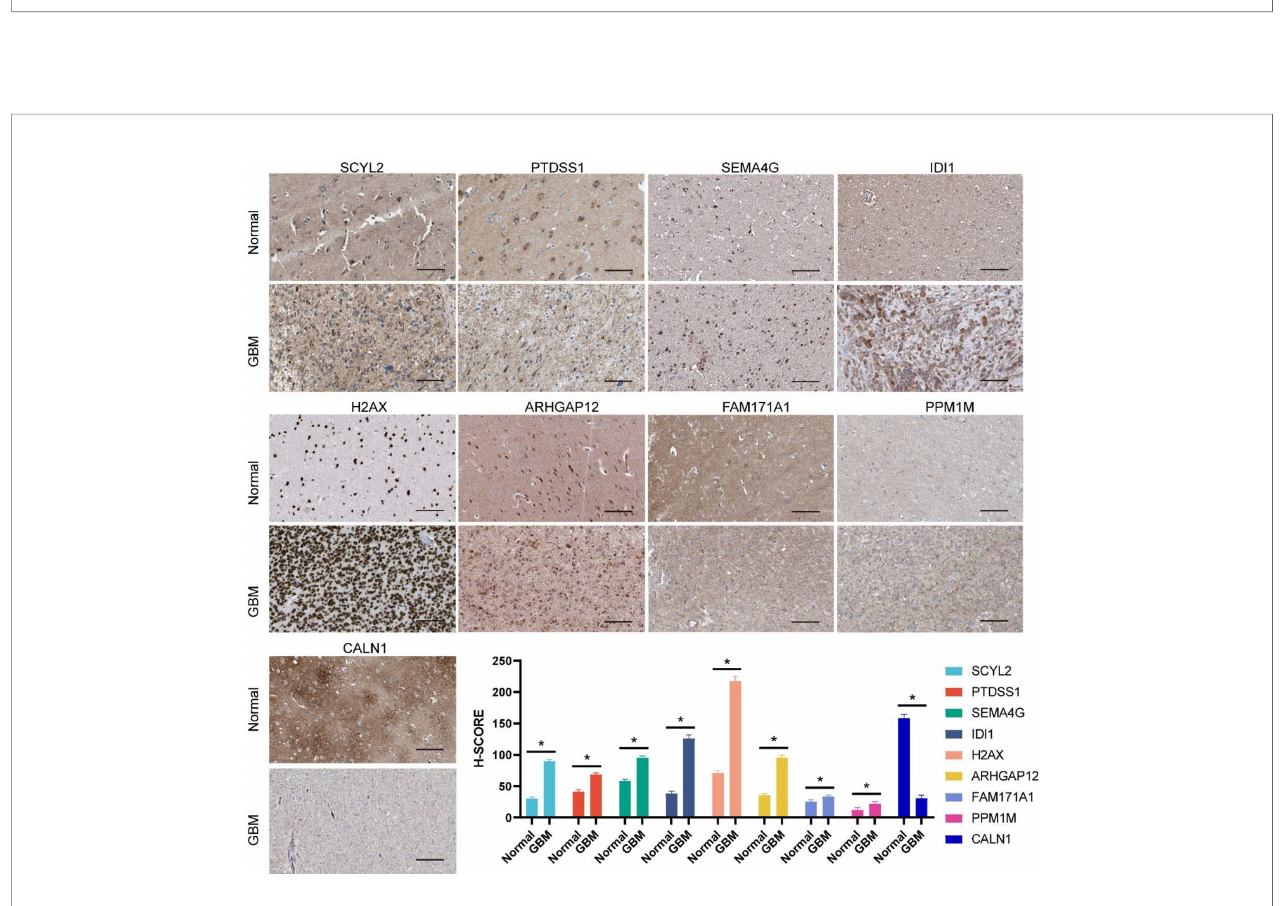
FIGURE 9 | Protein expression levels of genes incorporated in the prognostic model between normal brain and glioma tissue as demonstrated by immunohistochemical analysis and the H-SCORE analysis. Bar = 100µm. *p < 0.05.